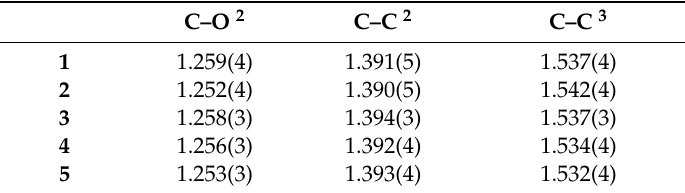
Table 3. Selected bond distances 1 (Å) for the Cl 2 An 2 − moiety in 1 – 5